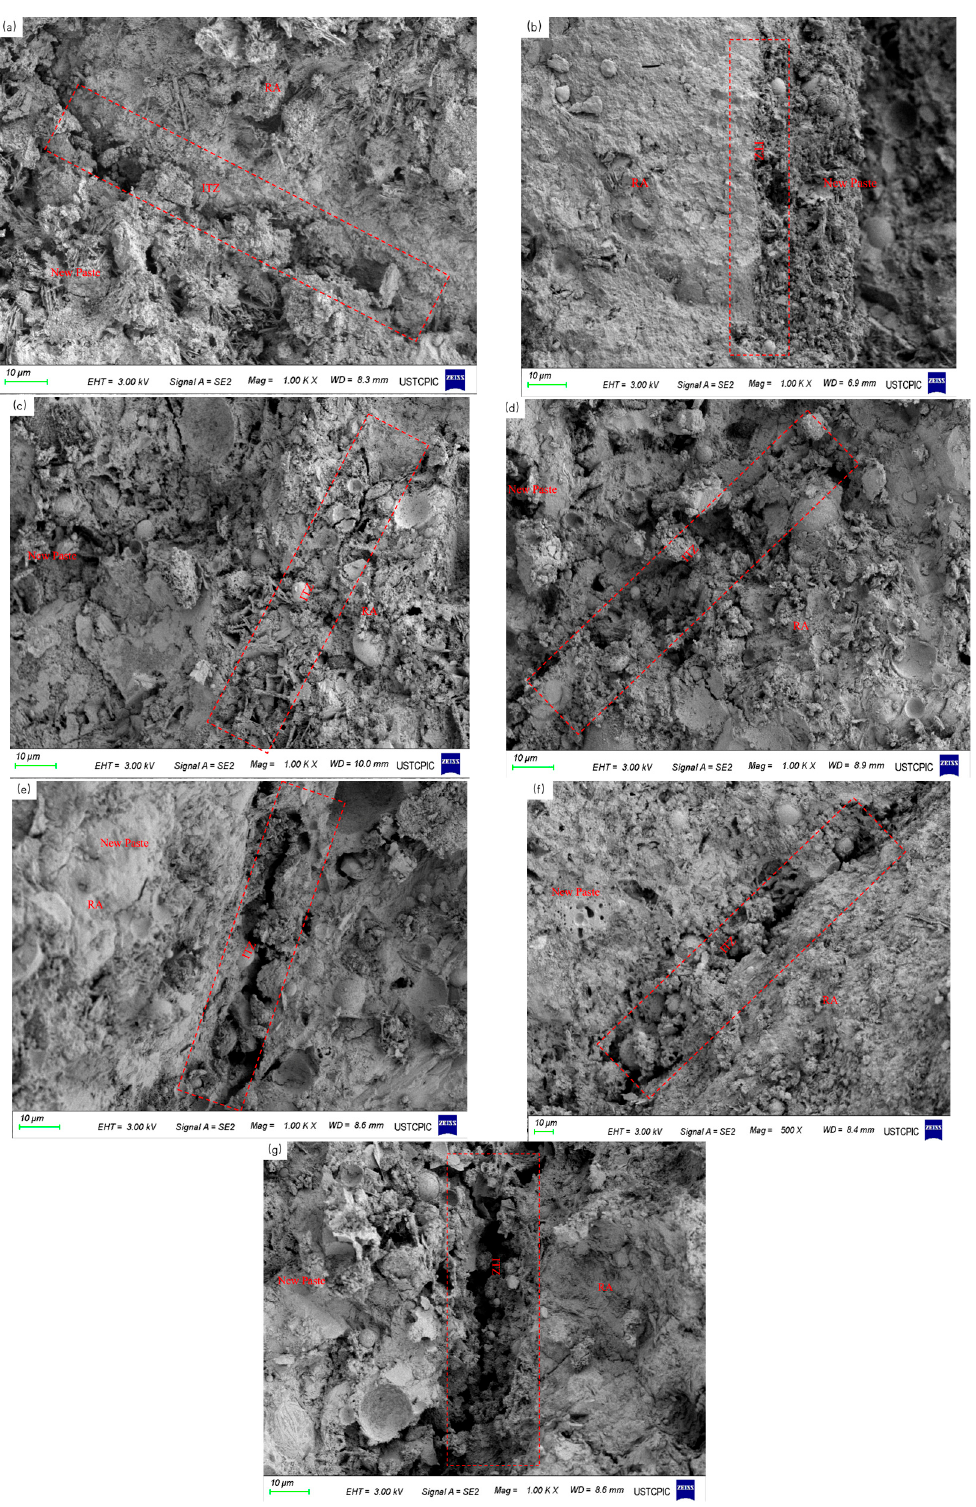
Figure 18. SEM images of the interfacial transition zone of the recycled concrete: ( a ) AD; ( b ) W50; ( c ) W55; ( d ) W60; ( e ) W65; ( f ) W75; ( g ) W100.